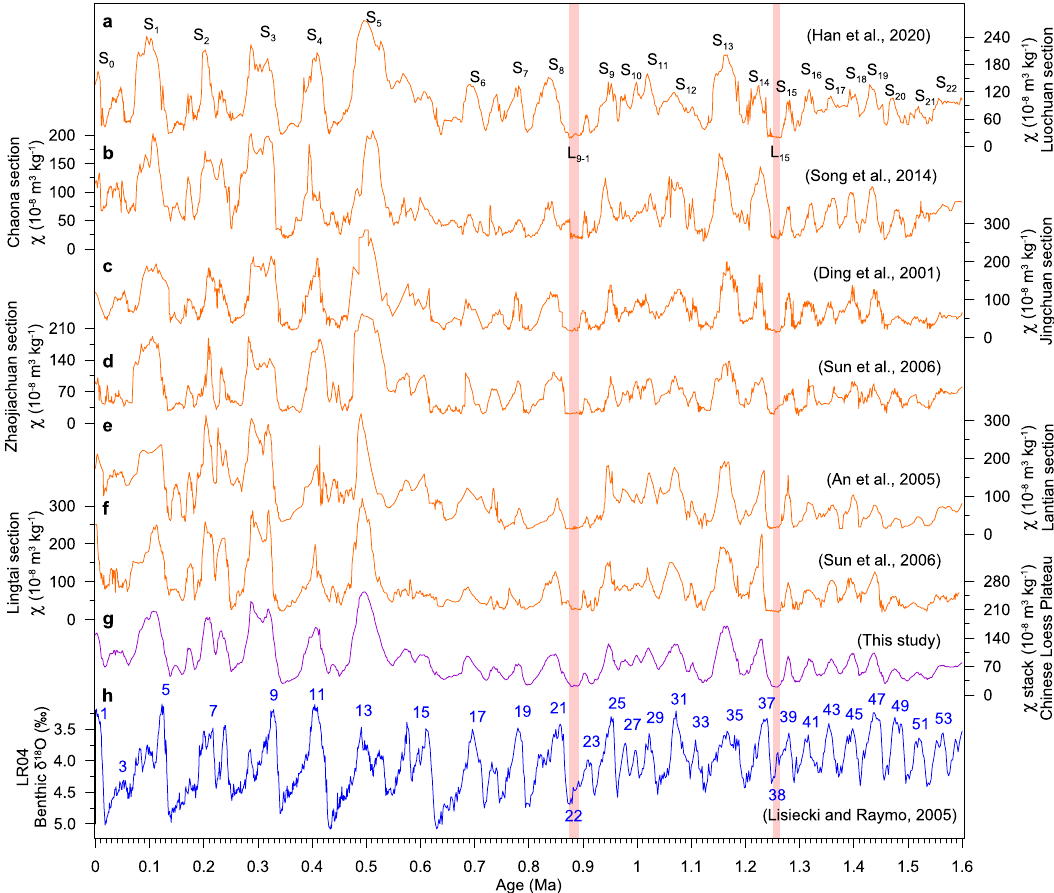
Fig. 3 Magnetic susceptibility variations of loess-palaeosol sequences across the Chinese Loess Plateau. Magnetic susceptibility ( χ ) records from the a Luochuan 43 , b Chaona 42 , c Jingchuan 45 , d Zhaojiachuan 29 , e Lantian 46 , and f Lingtai 29 loess-palaeosol sections across the CLP on our re fi ned loess- palaeosol chronology. g Chinese Loess Plateau χ stack (this study). h LR04 marine benthic δ 18 O record 47 . S-numbers refer to consecutive palaeosol horizons counting back from the present day. Numbers on the benthic δ 18 O record refer to Marine Isotope Stages, counting back from the present day. Pink bars indicate the correlation of χ of marker loess layers (L 15 and L 9-1 ) to glacial stages (marine isotope stages 38 and